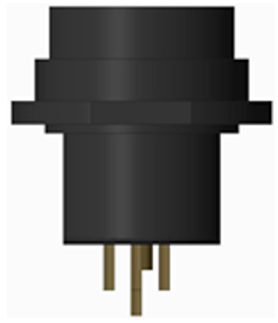
Figure 7. Watertight connector.